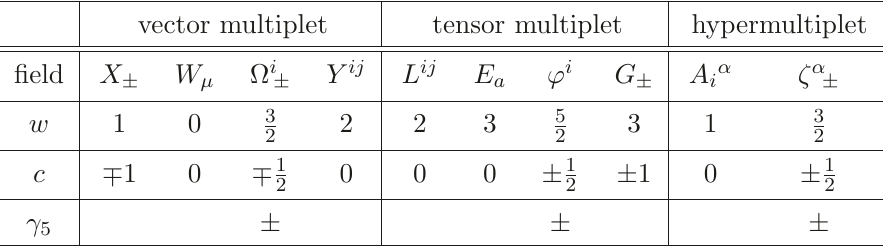
Table 4 . Weyl weights w , chiral SO(1 , 1) weights c , chirality γ 5 of the spinors for the 4 D Euclidean vector multiplet, the tensor multiplet and the